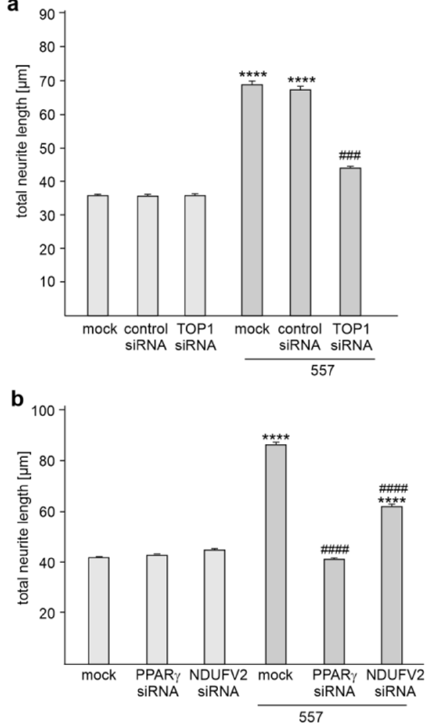
Figure 5. Reduction of TOP1, PPAR γ or NDUFV2 expression inhibits L1-dependent neurite outgrowth. ( a , b ) Cortical neurons were mock-transfected or transfected with control siRNA, TOP1 siRNA, PPAR γ siRNA or NDUFV2 siRNA. Neurons were then treated without or with L1 antibody 557. ( a , b ) Mean values + SEM from three independent experiments are shown for total neurite lengths (**** p < 0.001 relative to mock-transfected non-stimulated neurons, ### p < 0.005, #### p < 0.001 relative to mock-transfected stimulated neurons; one-way ANOVA with Dunn’s multiple comparison test).